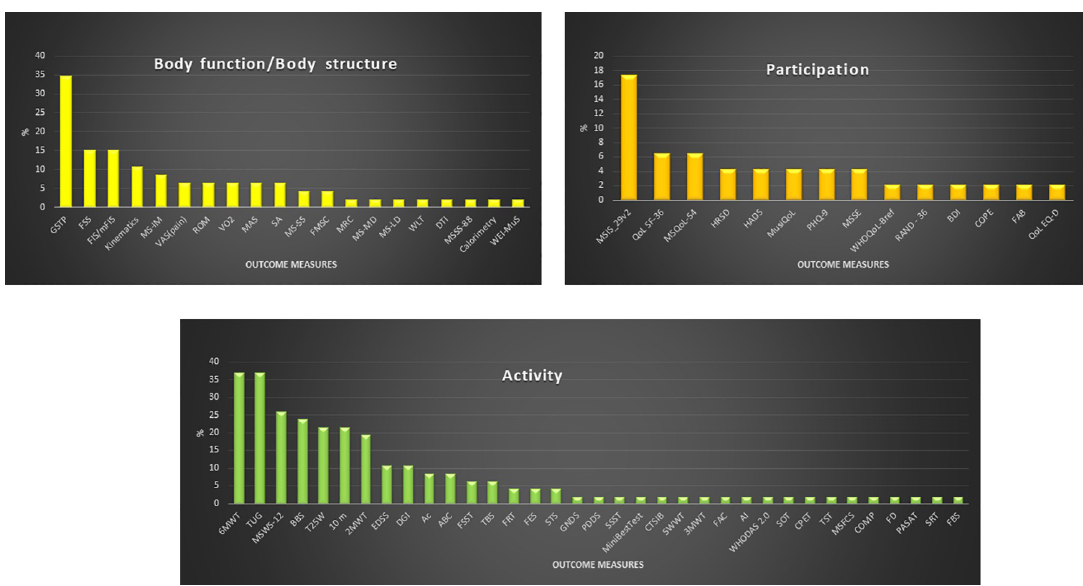
Fig 3. Outcome measures used according to ICF (% of use). Abbreviations: GSTP Gait spatiotemporal parameters; FSS Fatigue severity scale; FIS/mFIS Fatigue impact scale/modified fatigue impact scale; MS-IM Muscle strength isokinetik measure; VAS (pain) Visual analogic scale (pain); ROM Range of motion; VO2 peak oxygen uptake; MAS Modified Ashworth scale; SA Stabilometric assessment; MS-SS: Muscle strength static strength; MSC Fatigue scale for motor and cognitive function; MRC Medical research council; MS-MD Muscle strength mechanical device; MS-LD Muscle strength lokomat device; WLT Working load in treadmill; DTI Diffusion tensor imaging; MSSS-88 Multiple sclerosis Spasticity Scale– 88; WEI-MuS Wurzburg Fatigue Inventory for Multiple Sclerosis; MSIS-29 Multiple sclerosis Impact Scale_29; QoL SF-36 Quality of life short form 36; MSQoL-54 Multiple sclerosis quality of life; HRSD Hamilton rating scale for depression; HADS Anxiety and depression scale; MusiQoL Multiple Sclerosis International Quality of Life scale; PQH-9 Patient health questionnaire; MSSE Mini mental state examination; WHOQoL-Bref WHO quality of life-bref; RAND-36 Random 36 health survey; BDI Beck depression inventory; COPE Coping Orientation to Problem Experienced; FAB Frontal assessment battery; QoL-EQD Euro quality of life; 6MWT 6-minute walking test; TUG Timed up and go test; MSWS-12 Multiple sclerosis walking scale-12; BBS Berg balance scale; T25W Timed 25-foot walk; 10m 10-meter walking test; 2MWT 2-minute walking test; EDSS Expanded disability status scale; DGI Dynamic gait index; Ac Accelerometers; ABC Activities-specific balance confidence scale; FSST Four step square test; TBS Tinetti balance scale; FRT Functional reach test; FES Falls efficacy scale; STS Sit to stand test; GNDS Guy’s Neurological Disability Scale; PDDS Patient Determined Disease Steps; SSST Six spot step tests; Mini Best Test Mini best test; CTSIB Test for sensory interaction and balance; 5MWT 5-minute walking tests; 3MWT 3-minute walking test; FAC Functional ambulatory scale; AI Ambulatory index; WHODAS 2.0 World health organization disability assessment Schedule; SOT Sensory organization test; CPET Maximal cardiopulmonary exercise test; TST Timed stair test; MSFCS Multiple sclerosis functional composite; COPM Canadian occupational performance measure; FD Falls diary; PASAT Paced auditory serial attention test; SRT sit and reach test; FBS Fullerton balance scale.